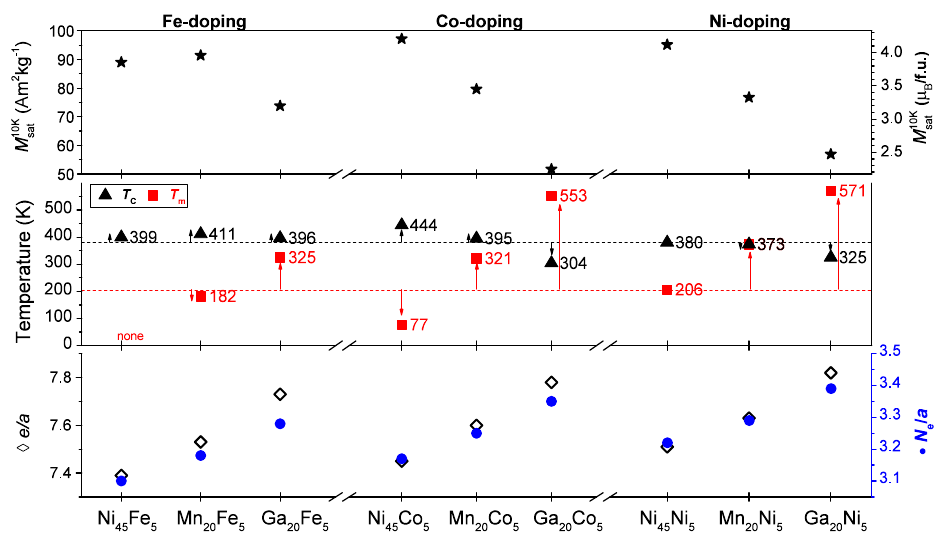
Figure 4. Transition temperatures dependence on composition. The full alloy compositions are shown in Table 1. The relative shift compared to stoichiometry alloy Ni 45 Ni 5 is marked by arrows. The transformation temperatures of stoichiometry alloy are marked by dashed lines. In addition, saturation magnetization M 10K , valence electrons per atom e/a and effective valence electrons per sat atom N e / a parameters are shown for